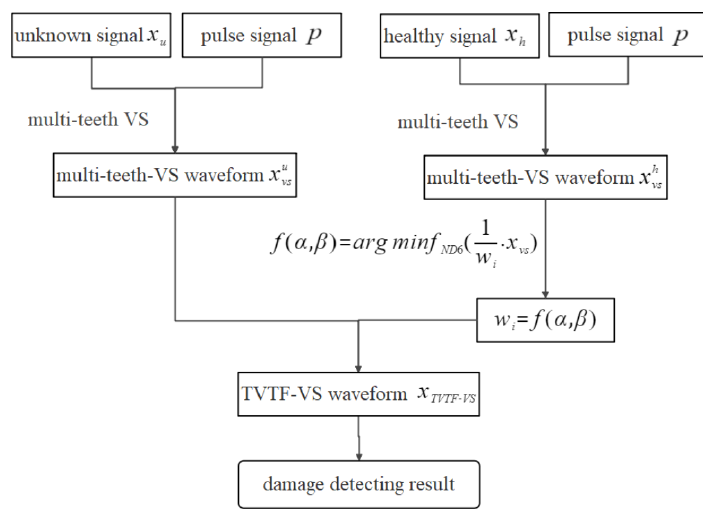
Figure 5. Technical route of fault detecting by the